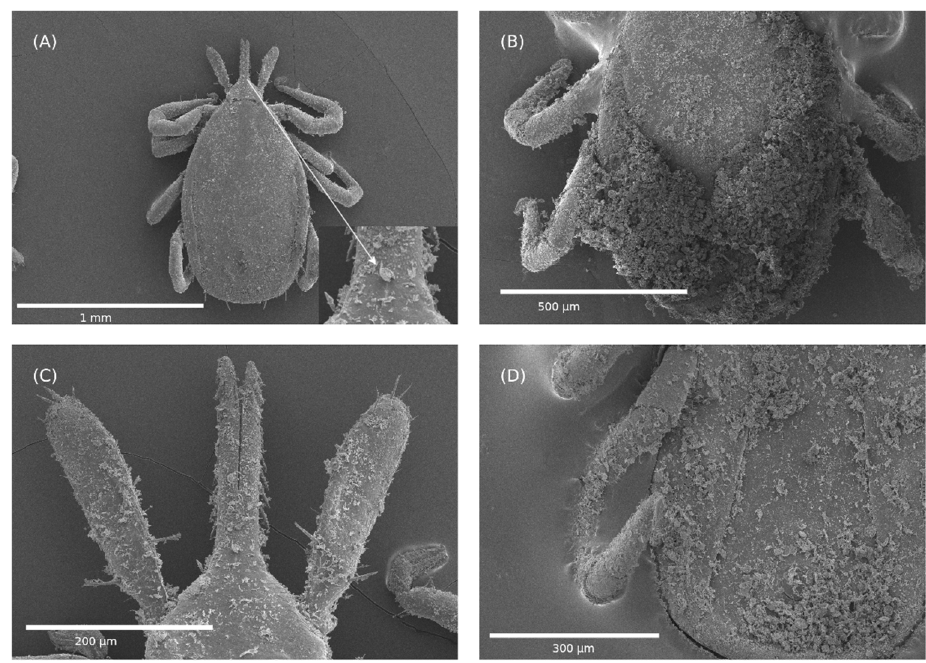
Figure 4. Scanning electron micrographs of Ixodes scapularis unfed nymphs exposed to Celite 610 by